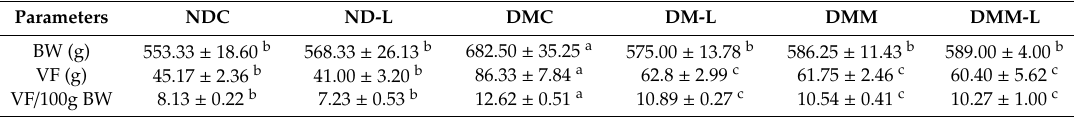
Table 1. E ff ects of L. paracasei HII01 on BW, VF weight and VF / 100 g BW in experimental